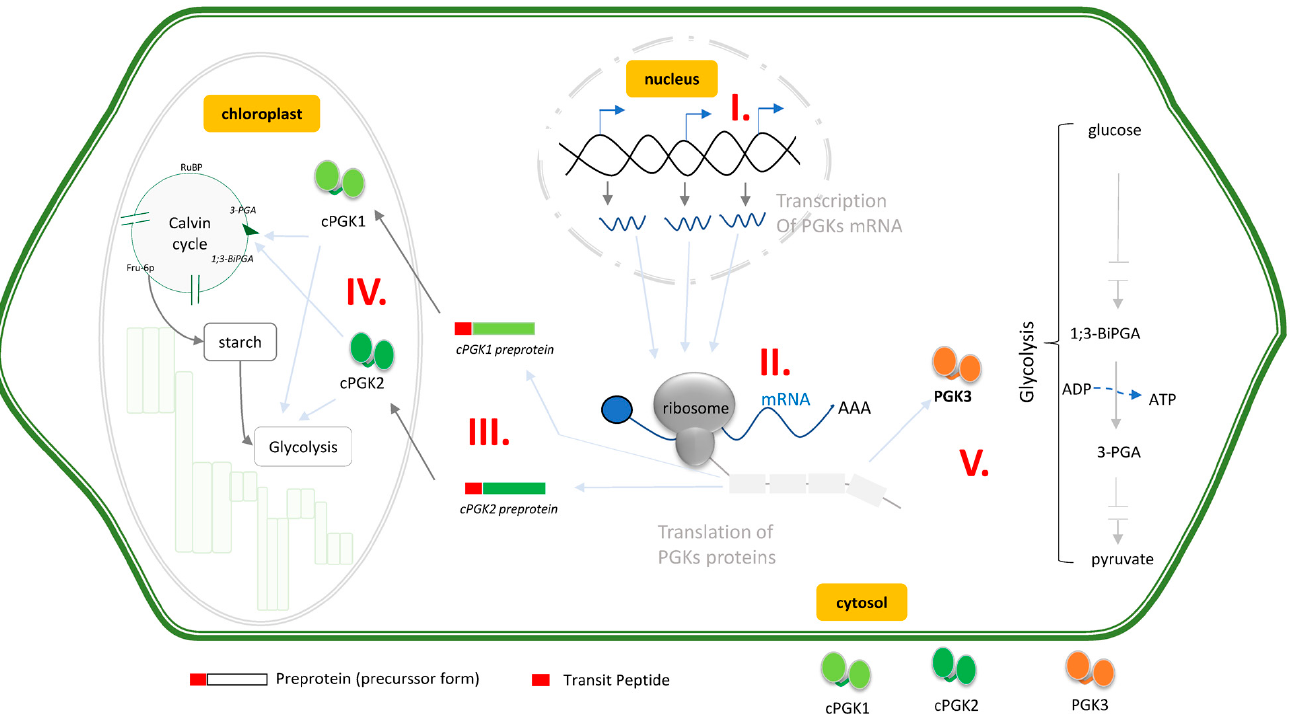
Figure 4. Arabidopsis phosphoglycerate kinases (PGK) localizations and functions in plant cell. Arabidopsis have 3 PGKs genes located in the nucleus (I) and encode two chloroplastic forms (IV, cPGK1 and cPGK2) and a cytosolic form (V, PGK3) [27]. Chloroplastic forms are translated in precursor proteins (III), which is subsequently targeted in the chloroplast, thanks to its N-terminal transit peptide (TP, red rectangle). These forms will be processed after chloroplast translocation to yield mature proteins (IV) without the transit peptide [39]. cPGK1 (light green) and cPGK2 (dark green) are assumed to be involved in the Calvin cycle and in chloroplast localized glycolysis. PGK3 (V), which is cytosolic, is assumed to be the glycolytic isoform [27] involved in cytosolic glycolysis, a sequential breakdown of glycose by numerous enzymes, yielding pyruvate. The compounds produced in glycolysis and the Calvin cycle are: RuBP: ribulose biphosphate; 3-PGA: phosphoglycerate kinase; 1,3-BiPGA: 1,3-biphospoglycerate; Fru-6p: fructose